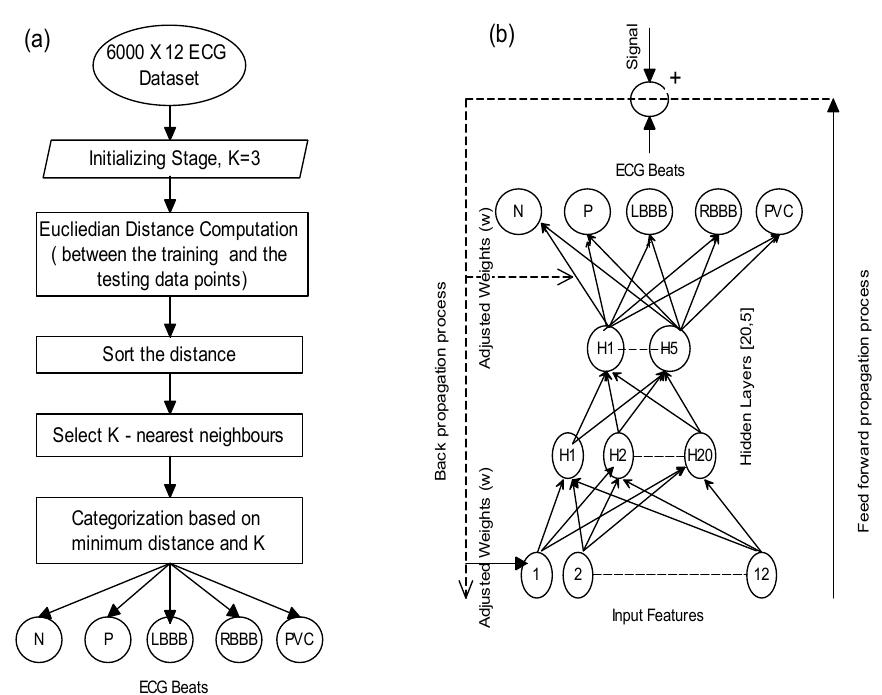
Figure 4 . Implemented Classifiers. (a) KNN Model, (b) FNN and BPNN Model